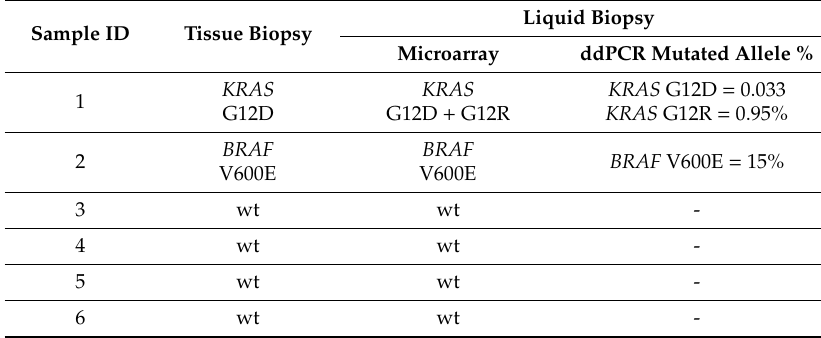
Table 2. Patients enrolled and corresponding mutational analysis on tissue biopsy and liquid biopsy at the T0 time-point by microarray and ddPCR